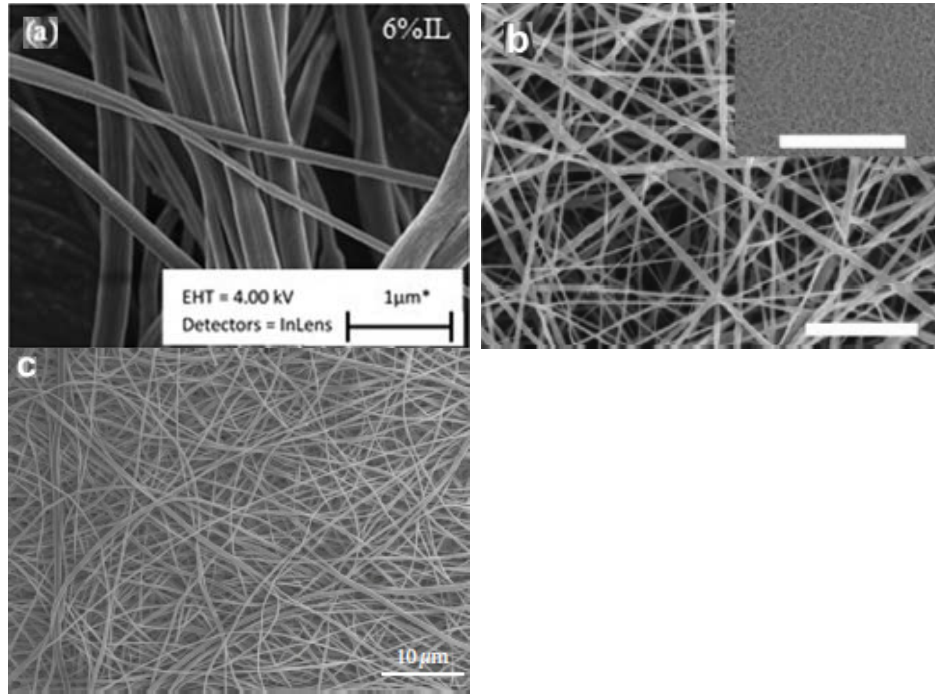
Figure 7. SEM micrographs of ( a ) electrospun cellulose acetate fibers [25]; ( b ) electrospun PLA fibers [39]; and ( c ) electrospun gelatin fibers [33] assisted by different ionic liquids as additives.